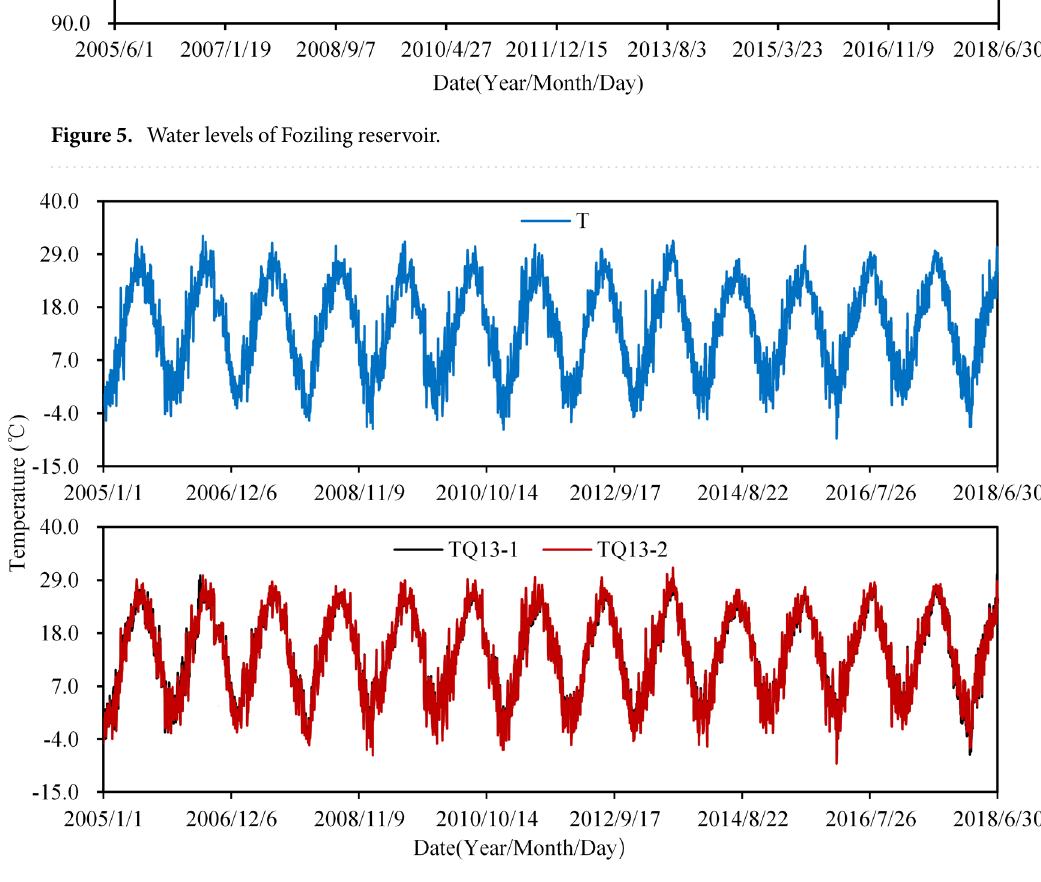
Figure 6. Measured daily air